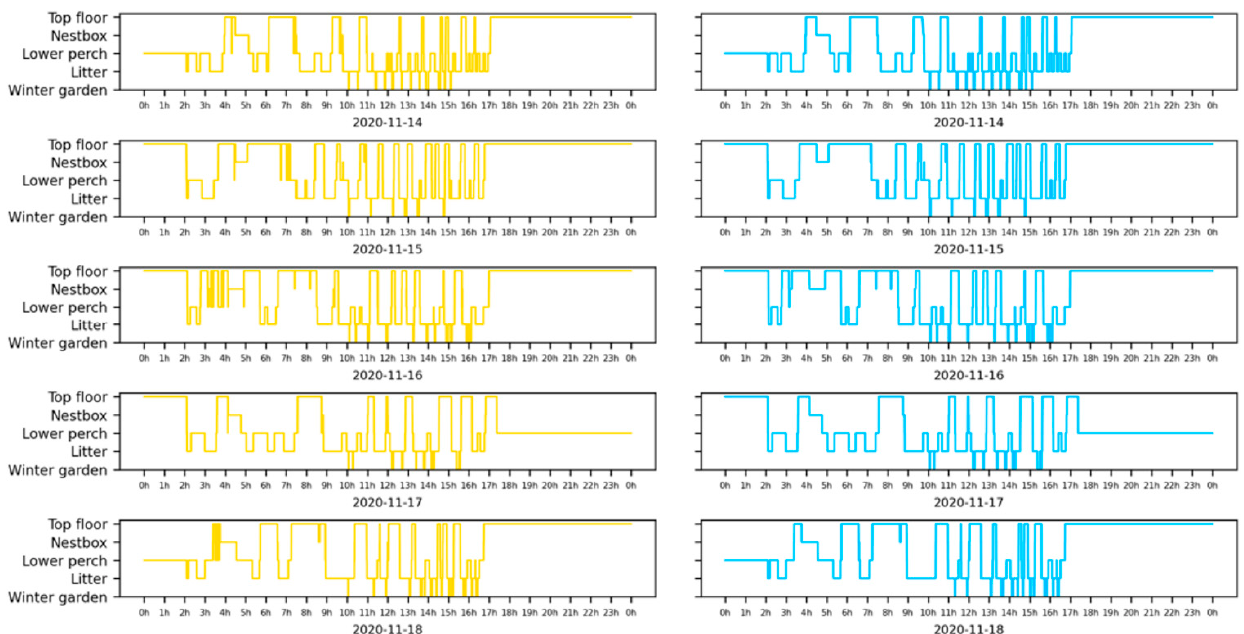
Figure 5. Estimated error rate (mean ± SD) for pen-zone areas.